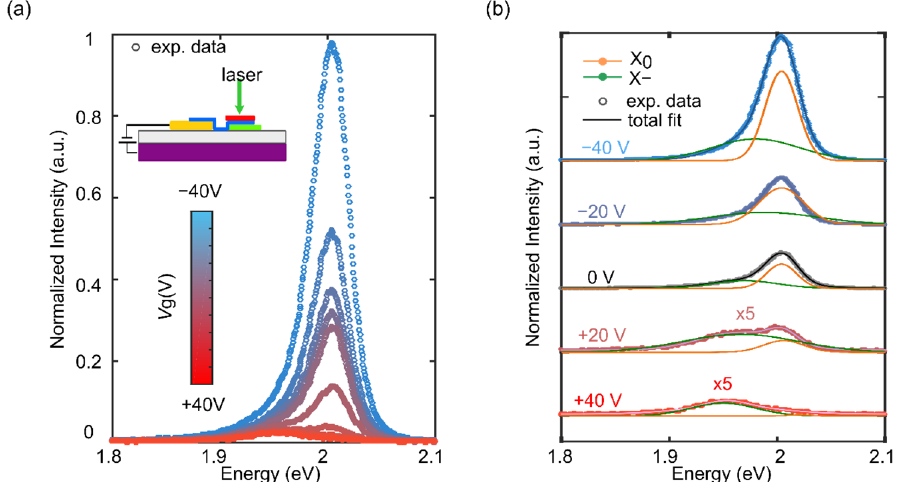
Figure 3. ( a ) Photoluminescence spectra of the 1L-WS 2 hBN-encapsulated region recorded at gate voltages between − 40 V and 40 V. Inset: schematic of the 1L-WS 2 sample and of the probed region. ( b ) Photoluminescence spectra recorded at − 40 V, − 20 V, 0 V, 20 V and 40 V gate voltages fitted each to two peaks coming from exciton (orange curve) and trion (green curve) emission.